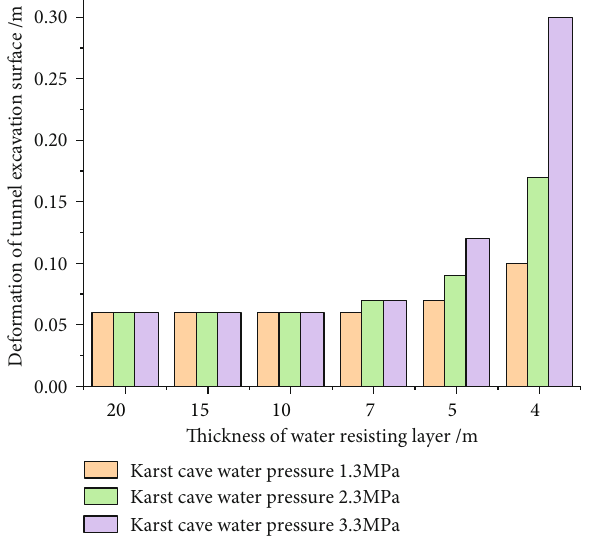
Figure 8: Displacement and deformation characteristics of tunnel face under di ff erent water pressure.